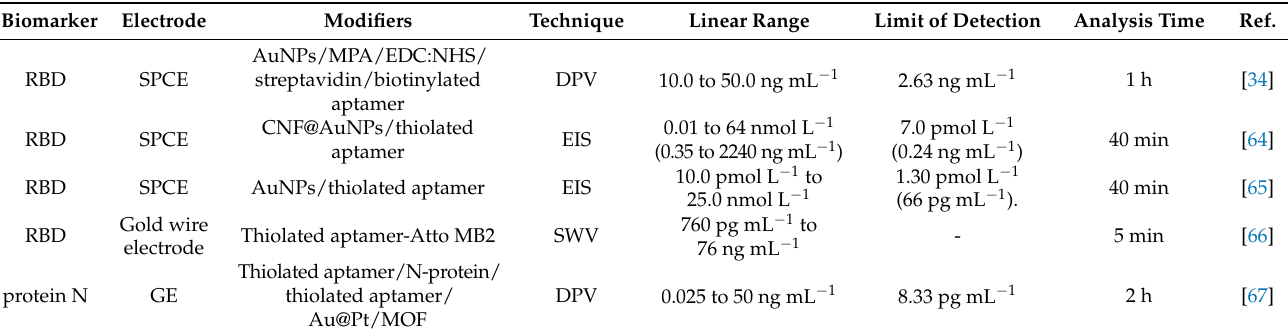
Table 4. Summary of electrochemical aptasensors for SARS-CoV-2